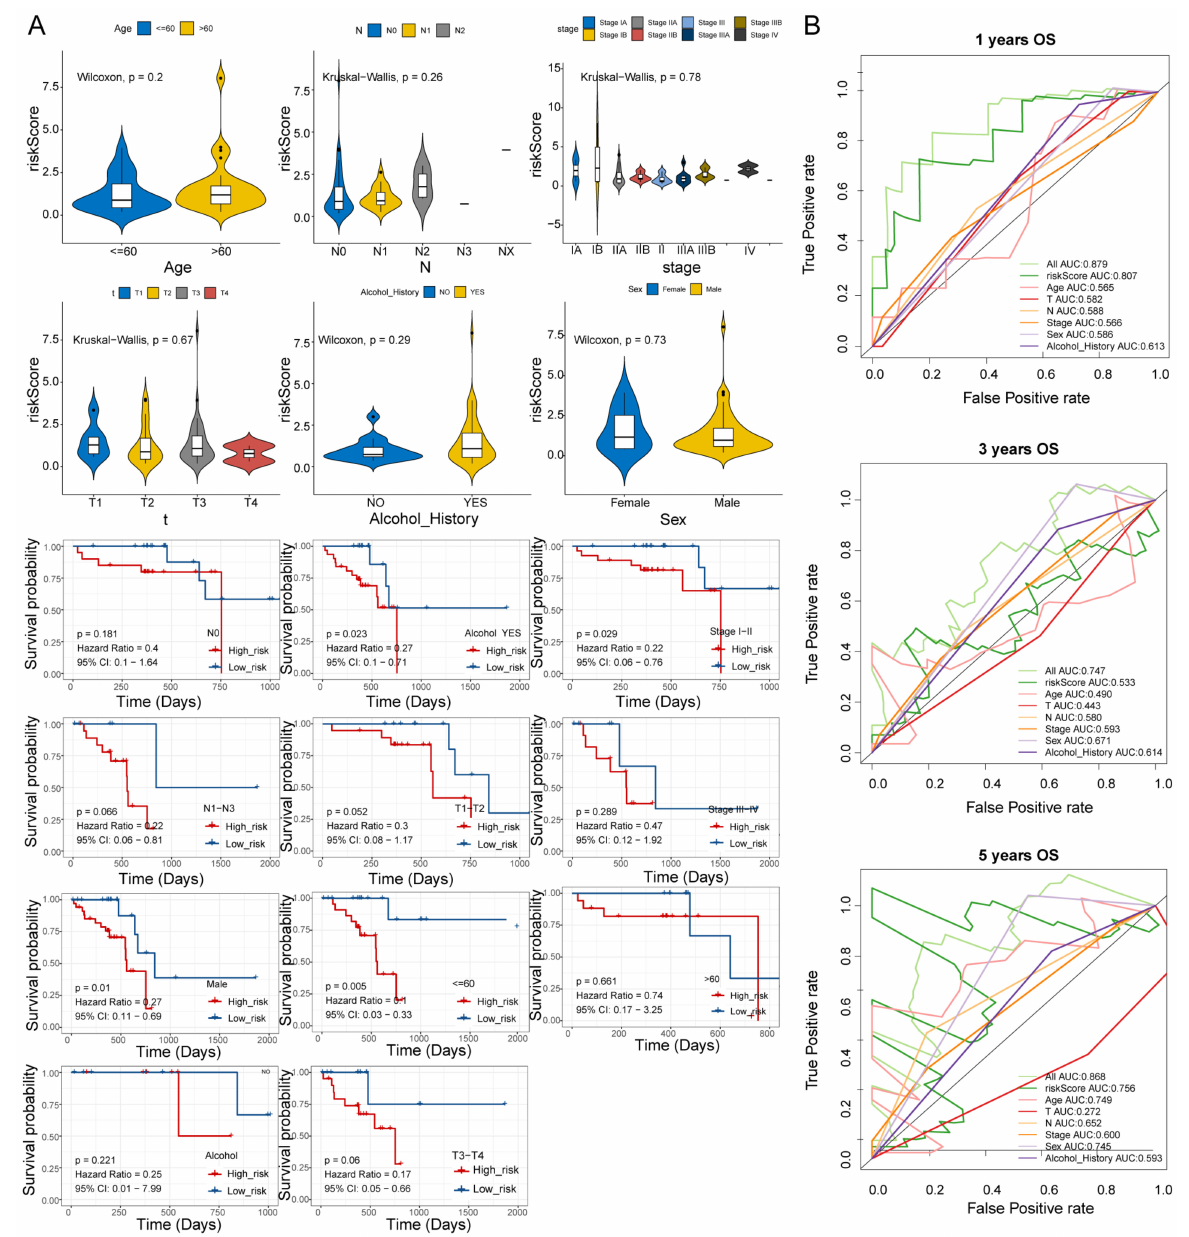
Figure 4. Correlation analysis of risk score and clinical traits. ( A ) Stratified survival analysis of risk scores and clinical traits. ( B ) ROC analysis of risk scores and clinical traits in patient